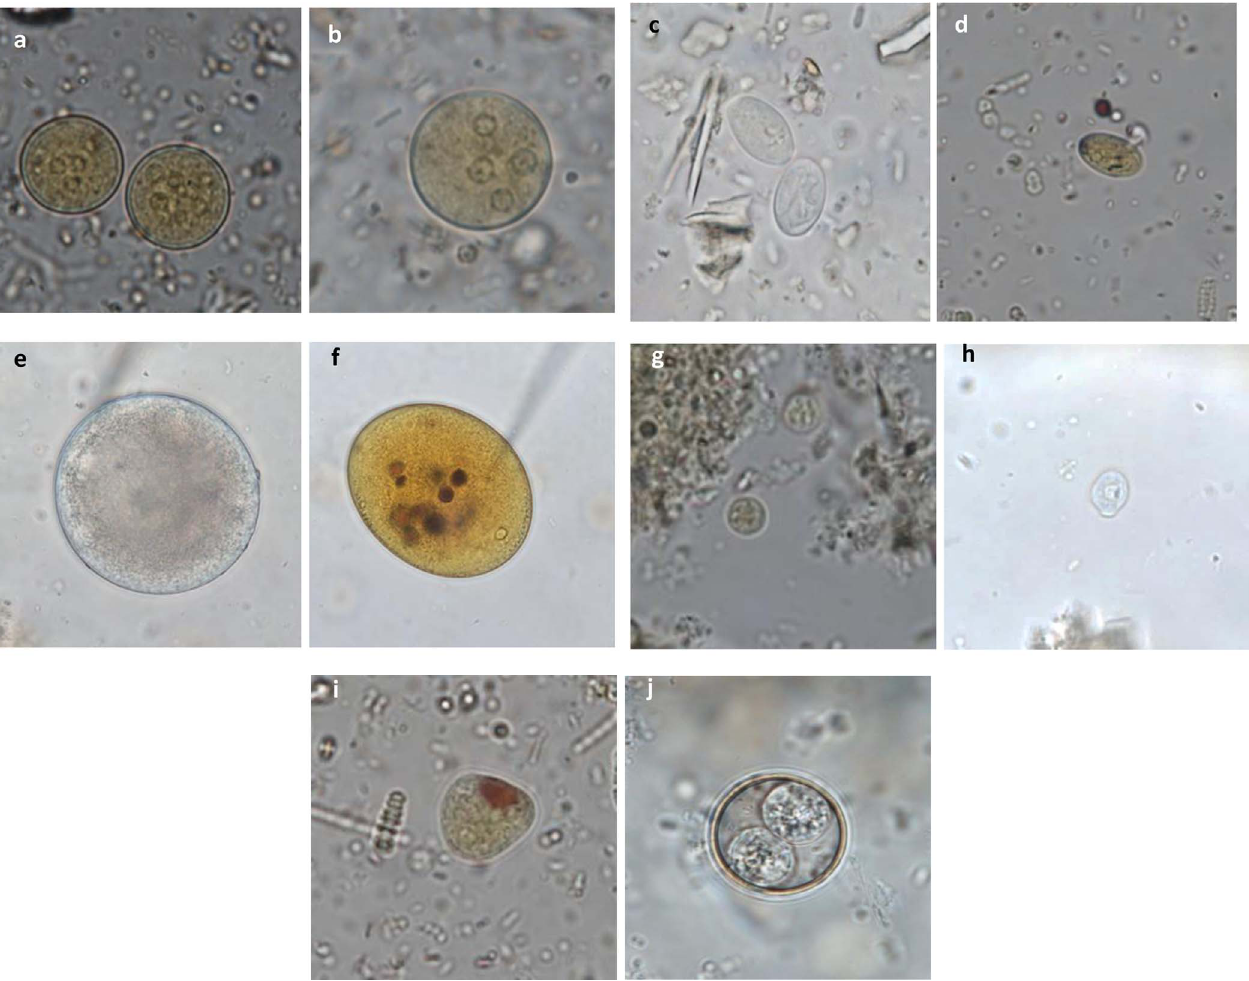
Figure 4. Diagnostic atlas for the identi fi cation of protozoan cysts in non-human primates. (a) Entamoeba sp. cysts stained with Lugol ( (cid:1) 100): eccentric nuclei with a voluminous endosome and granulomatous peripheral chromatin; (b) Entamoeba sp. cyst stained with Lugol ( (cid:1) 100); (c) Giardia intestinalis cysts ( (cid:1) 100): oval cysts of 8 – 12 l m with a thin outer membrane and 2 – 4 nuclei and a fl agellum; (d) Giardia intestinalis cyst stained with Lugol ( (cid:1) 100); (e) Balantioides coli cyst ( (cid:1) 100): spherical to ovoid cyst of 50 – 70 l m in diameter with a thick membrane, granular content, one macro- and one micronucleus; (f) Balantioides coli stained with Lugol ( (cid:1) 100); (g) Endolimax sp. cyst stained with Lugol ( (cid:1) 100): small round cysts with a thin outer membrane and 1 – 4 punctiform nuclei with voluminous, irregular endosomes without perisomes; (h) Chilomastix sp. cyst ( (cid:1) 100): small piriform cysts with a thin and refringent membrane, one nucleus and a cytostome containing the fl agellum; (i) Iodamoeba sp. cyst stained with Lugol ( (cid:1) 100): oval cysts with a small round nucleus containing a large vacuole, and a peripheral iodophilic voluminous vacuole; (j) Isospora sp. sporulated oocyst ( (cid:1) 100): round cysts containing 2 sporocysts with 4 sporozoites